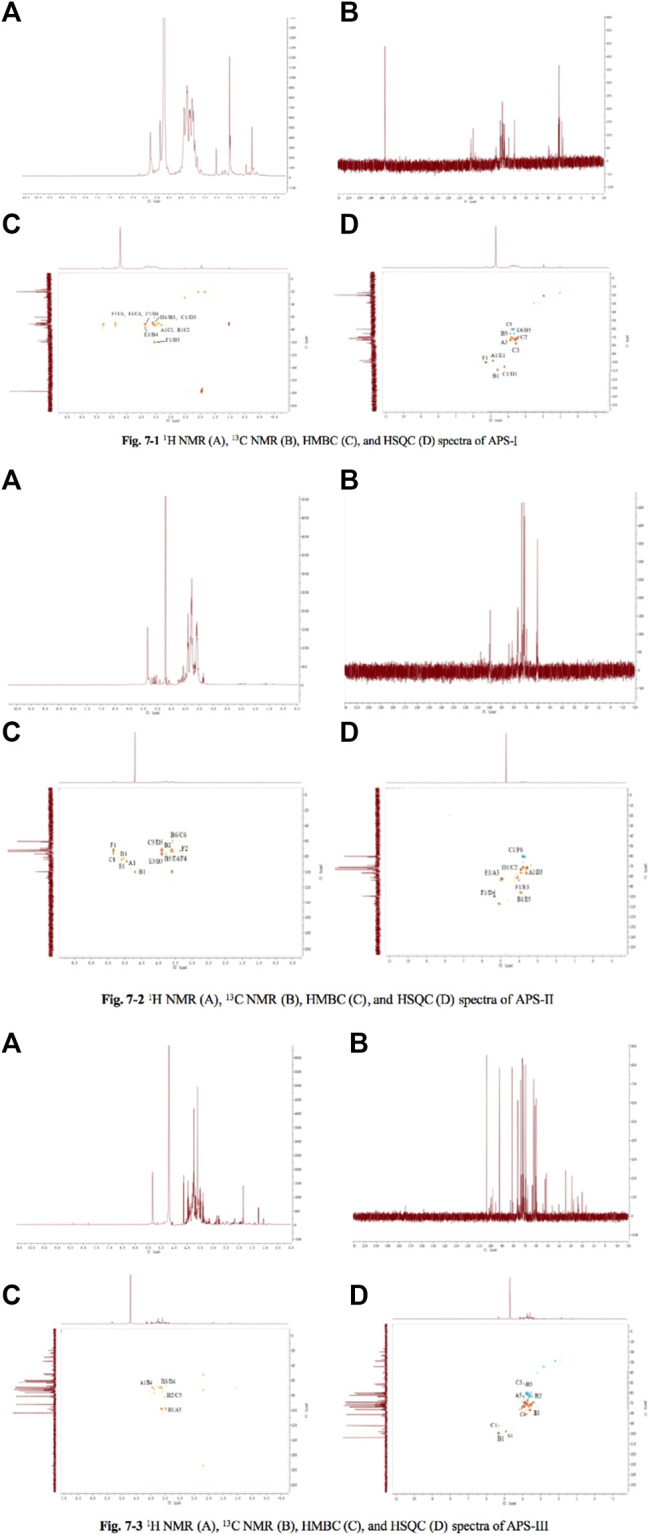
The 1H NMR, 13C NMR, HMBC, and HSQC spectra of APS-Ⅰ (A), APS-Ⅱ (B) and APS-Ⅲ (C).